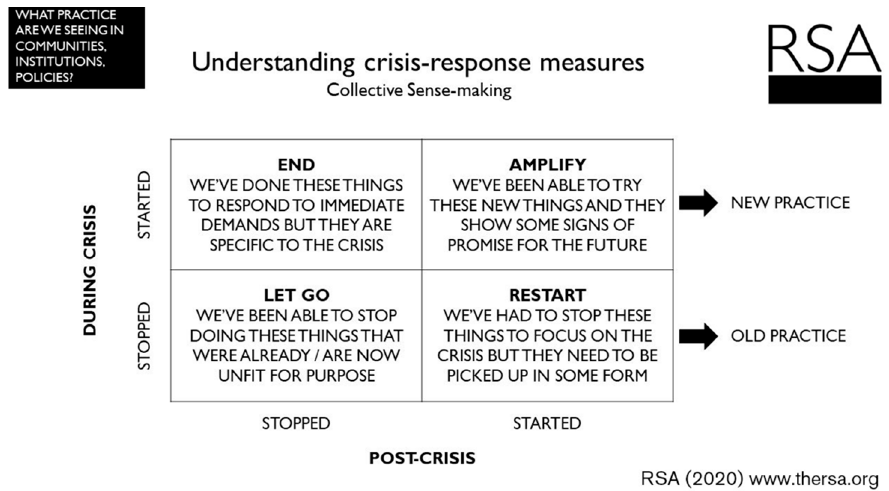
Figure 4. A framework to understand crisis-response measures copied with permission from Royal Society for Arts Manufactures and Commerce, (2020) [71].